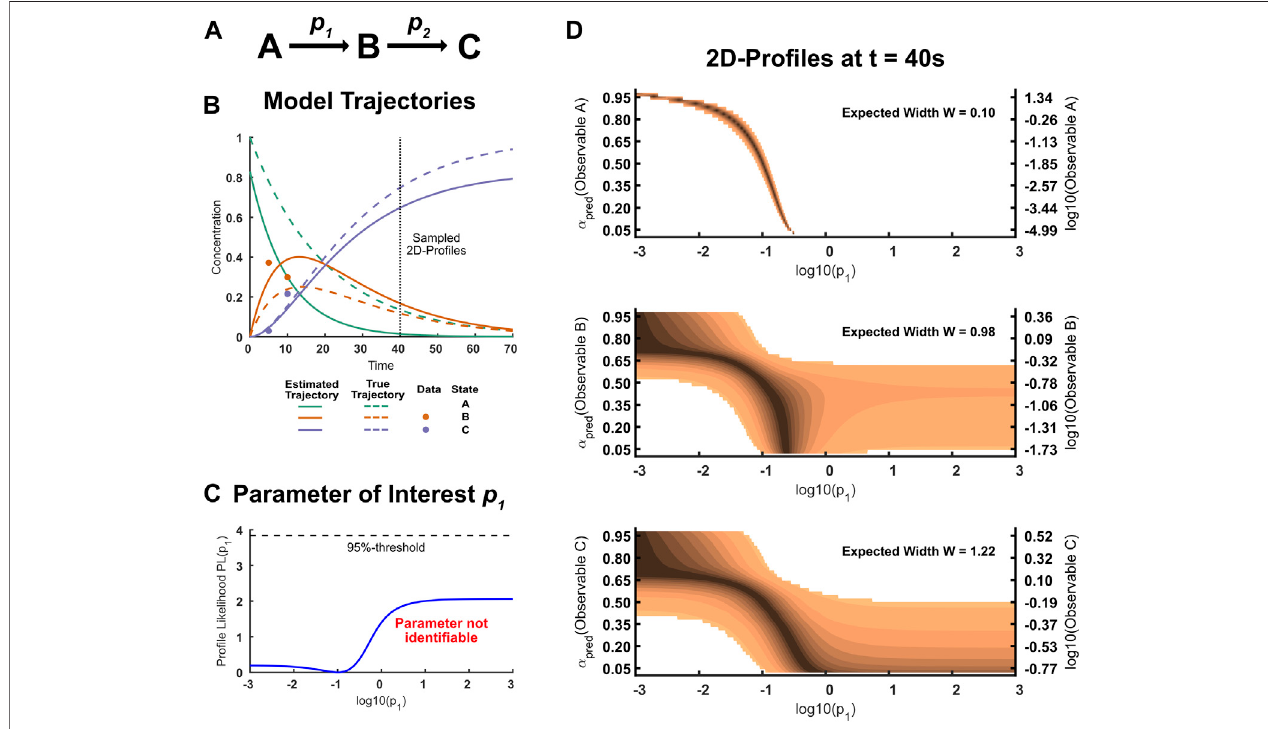
FIGURE 3 | (A) : States and parameters in the ABC-model. The model has three parameters: Two rate constants p 1 and p 2 , and the initial concentration A 0 . The initial concentrations of B and C are assumed to be zero. (B) : Trajectories of the ABC-Model. The dots correspond to the sparse data simulated from the true model. In thisexample,stateBandCwereassumedtobeobservable, buthaveonlybeenobservedat earlytimepoints. Thetrue trajectoryofstateAyetdiffersconsiderablyfrom the estimated trajectory. (C) : Likelihood pro fi le of the practically non-identi fi able parameter p 1 . Because the initial concentration of state A is unknown, this parameter is dif fi cult to estimate without information about state A. (D) : 2D-Likelihood pro fi les for the three states A, B and C if measured at time point t = 40. The illustratedpro fi lesarepresented onacon fi dencescaleaccordingto Figure1D .IfstateAwasobservable,the fi nitewidthofthe2D-pro fi le tothe95%levelindicatesthat any measurement outcome will make the parameter p 1 identi fi able. Note that possible values for A scatter across six orders of magnitude because the predictions for A are barely informed. Measuring state B or C will likely put an lower or upper limit on the parameter p 1